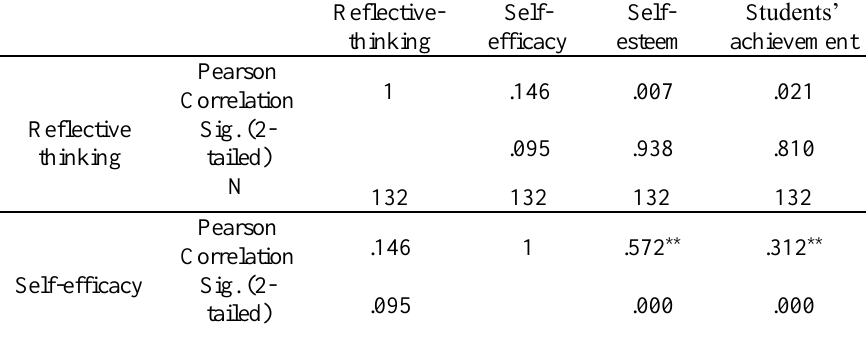
A correlation matrix investigating the relationship between reflective thinking, self- efficacy, self-esteem and academic achievement Reflective-